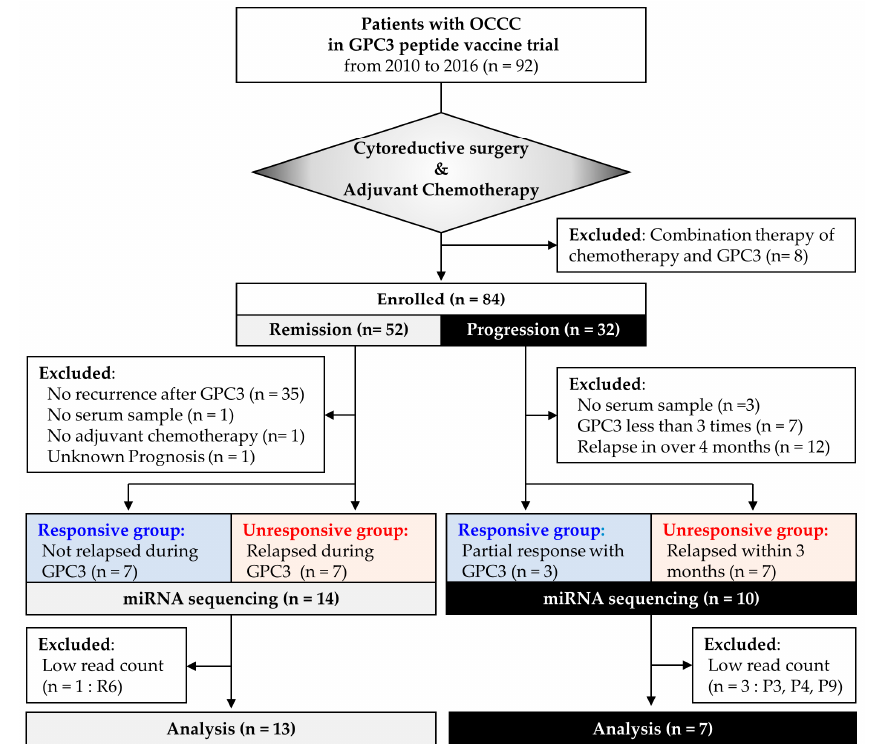
Figure 1. Patient flowchart. Patients with ovarian clear cell carcinoma enrolled in the glypican-3 trial were divided into remission and progression groups, and their archival serum samples were used for analysis. GPC3, glypican-3; R, remission; P, progression.